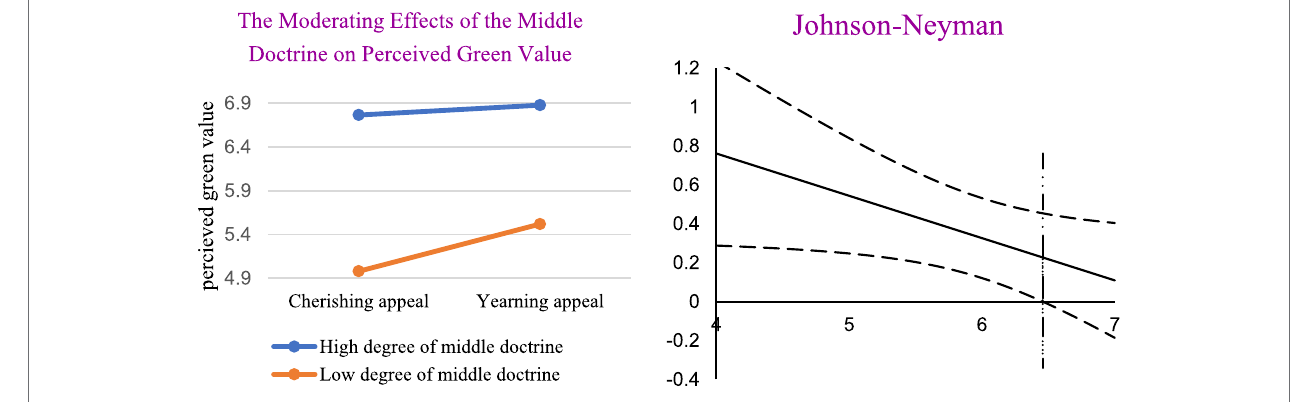
FIGURE 7 | The moderating effects of the middle doctrine on perceived green value and floodlight